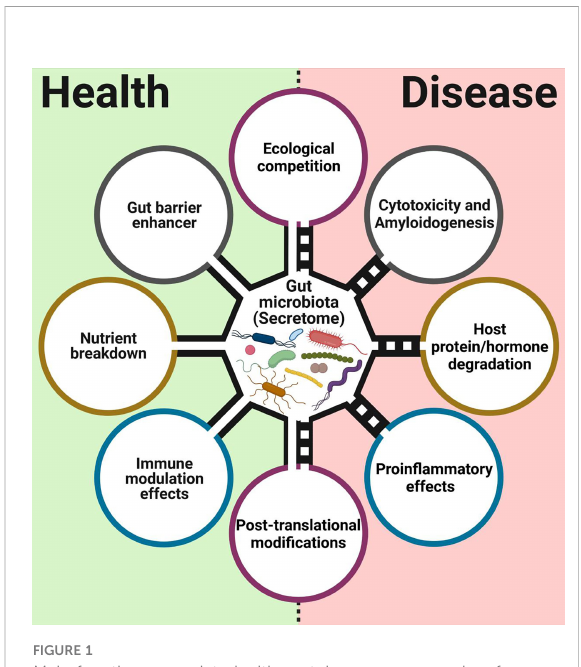
FIGURE 1 Main functions associated with proteins, enzymes, and surface layer proteins from commensals and probiotics bacterial intestinal. This fi gure was created with